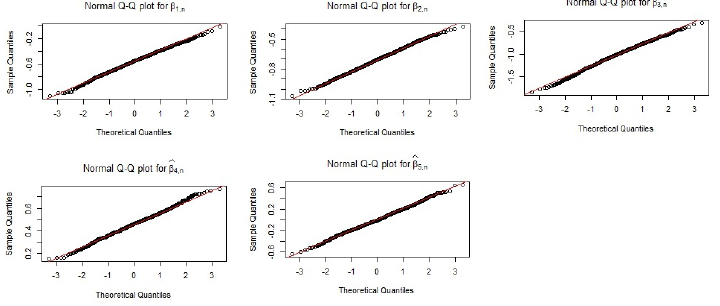
Fig. 4: Normal Q - Q plots for (cid:98) β 1 ,n ,..., (cid:98) β 5 ,n with results are gained from the N-R algorithm (n = 500)